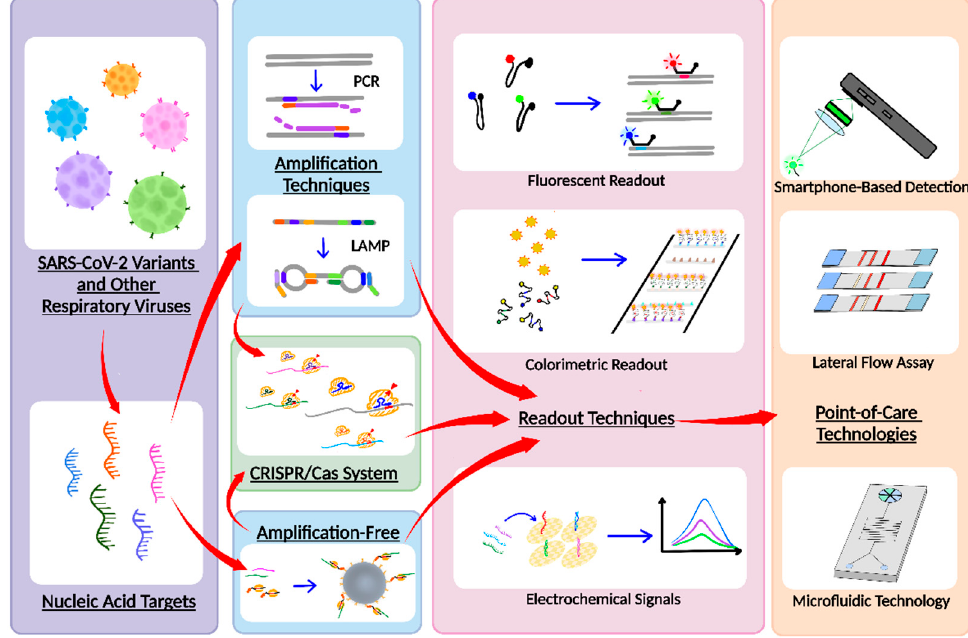
Figure 1. Overall schematic of multiplex nucleic acid diagnostic tests for combating SARS-CoV-2 variants and other respiratory viruses.